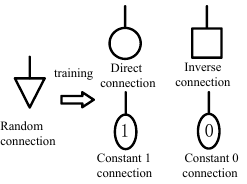
Figure 2. Connection states of a synapse.